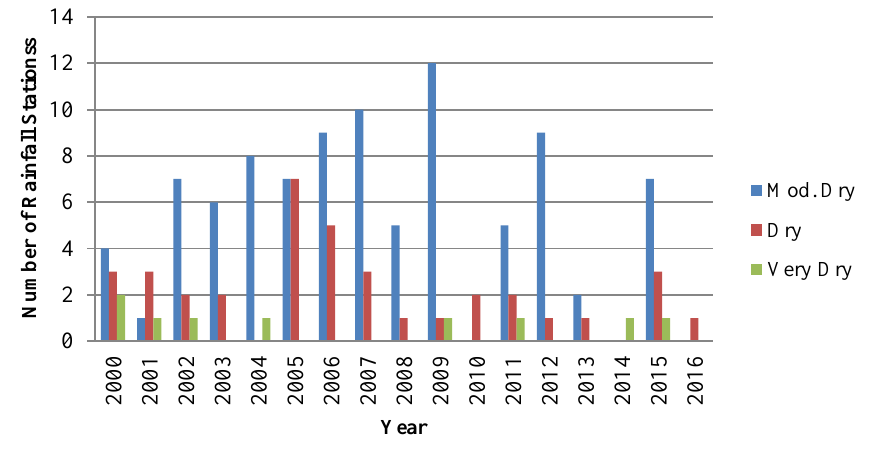
Figure 3. Number of rainfall stations experiencing moderately dry or worse conditions.